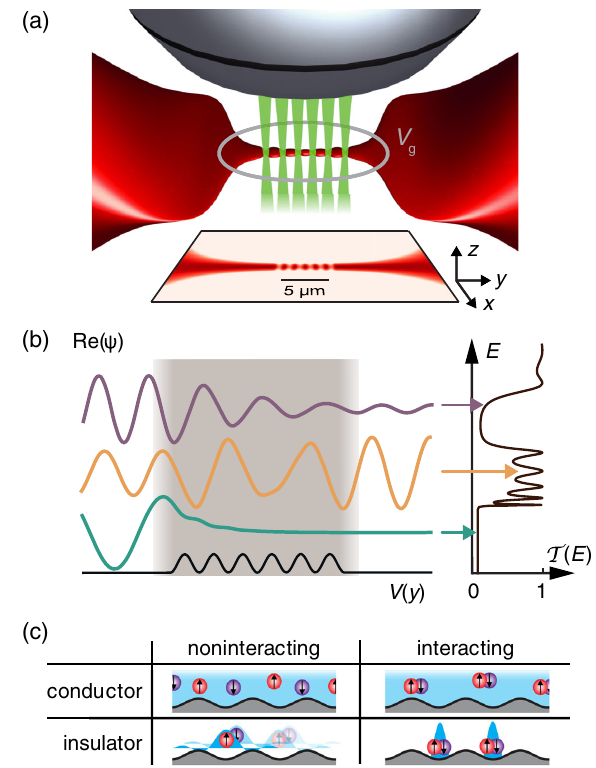
FIG. 1. Concept and experimental realization. (a) Sketch of a one-dimensional lattice projected onto a quantum wire that connects two macroscopic atom reservoirs. The lattice beam here is made up of six repulsive, holographically shaped barriers that are imaged into the atomic plane with a high-resolution microscope. The sites are spaced by 0 . 97 μ m. An attractive gate beam allows us to locally increase the chemical potential by an energy V . (b) Real part of the wave function ψ ð y Þ and trans- g mission T for a single atom incoming on a one-dimensional lattice of barriers for various energies E . T ð E Þ is zero for energies below the lattice zero-point energy (green arrow), and features a conduction band (yellow) and a band gap (purple). The nonzero transmission in the gap as well as the modulation in the conduction band originate from the finite size. (c) Possible insulating and conducting states for two-component fermions in a one-dimensional lattice. The atoms are delocalized at incommensurate densities and become localized at lattice fillings close to two particles per site. For strong attractive interactions, the conductor is made of extended pairs, and the insulator is made of pairs pinned to lattice sites. For noninteracting particles, the system forms a band conductor and a band insulator for incommensurate and commensurate fillings,